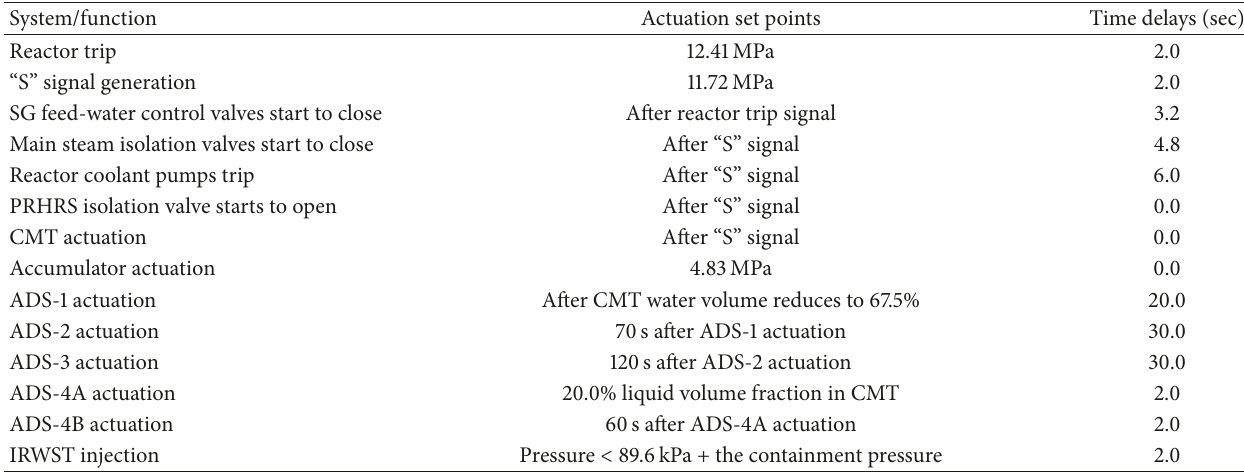
Table 1: AP1000 safety system actuation set point during SBLOCA [5].